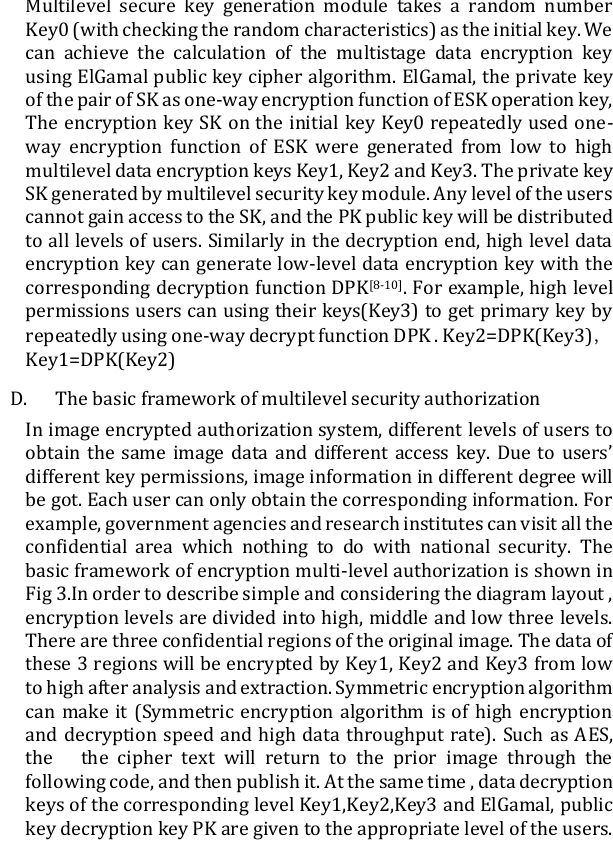
Figure 2. The architecture of the productionof multi-level key